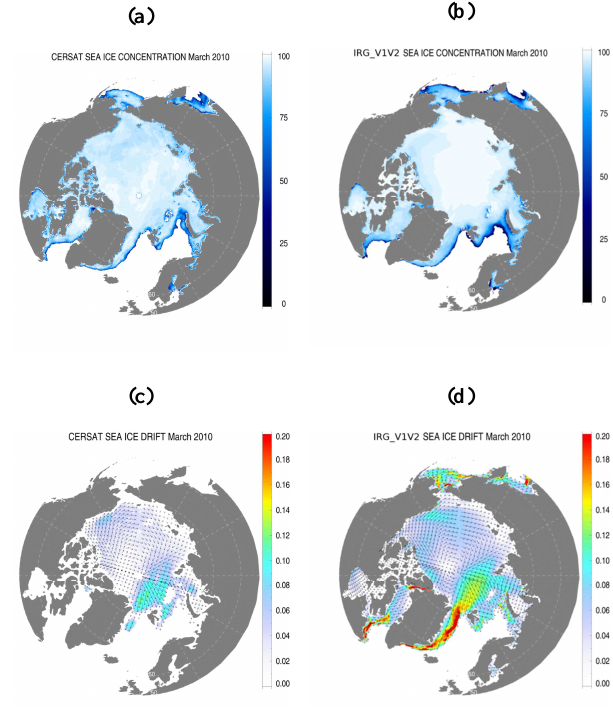
Fig. 10. Sea ice concentration (%) in the Arctic in March 2010: (a) Fig. 10. Sea-ice concentration (%) in the Arctic in March 2010: (a) from CERSAT satellite 2 from CERSAT satellite measurements, (b) from IRG V1V2. Sea ice drift (ms − 1 ) in the Arctic in March 2010: (c) from CERSAT measurements, (b) from IRG_V1V2. Sea-ice drift (m s -1 ) in the Arctic in March 2010: (c) 3 satellite measurements; (d) from IRG from CERSAT satellite measurements; (d) from IRG_V1V2. 4 5